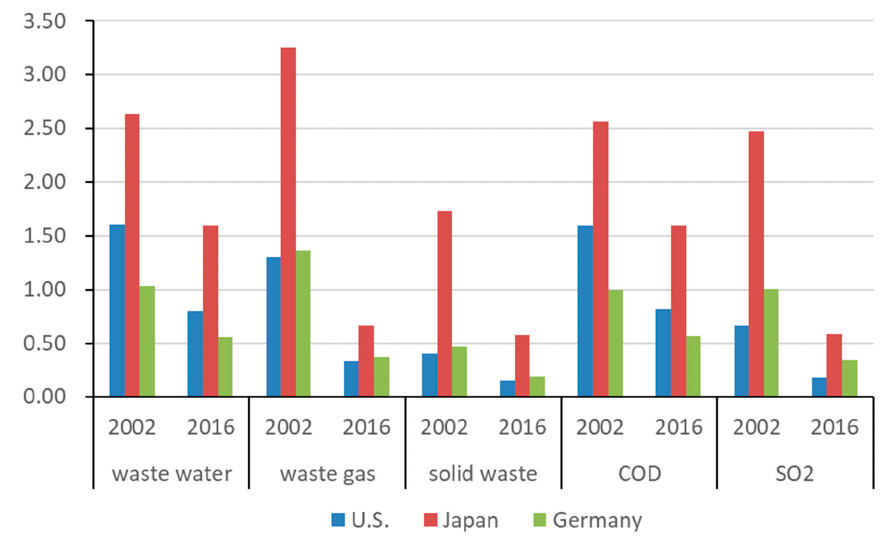
Figure 6. The revised PTT between China and US, Japan, and Germany.